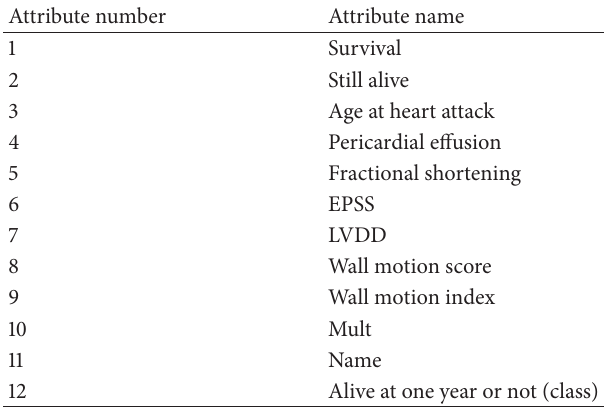
Table 4: Echocardiogram data set attribute information.